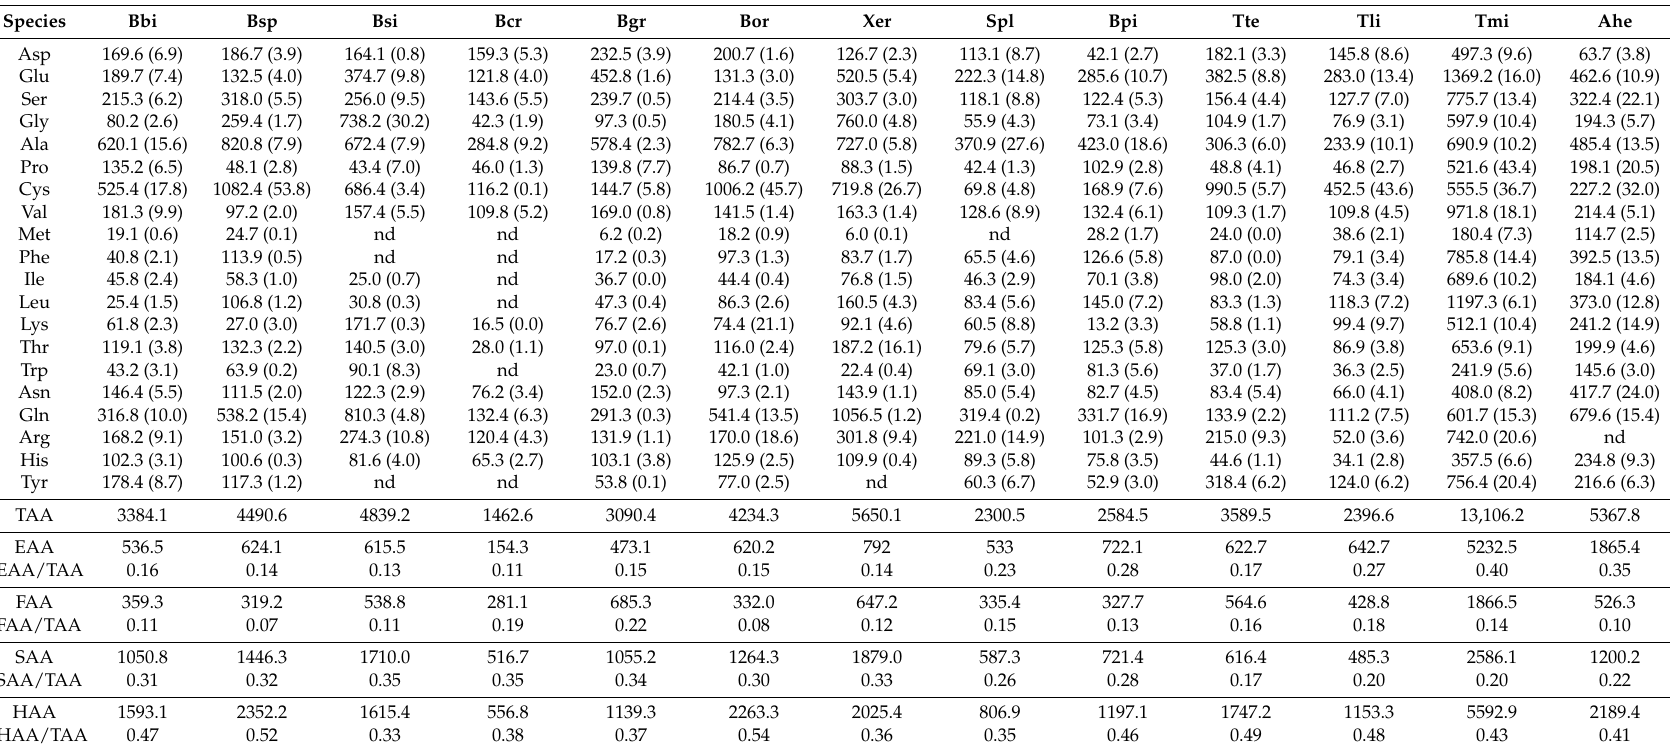
Table 1. Concentrations (Milligrams per 100 g) of Free Amino Acids in Mushroom